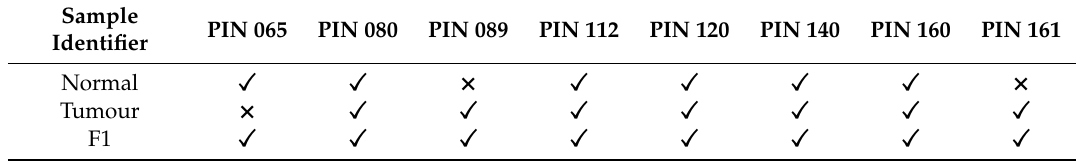
Table 4. Breakdown of samples included in microarray profiling and matched comparisons.